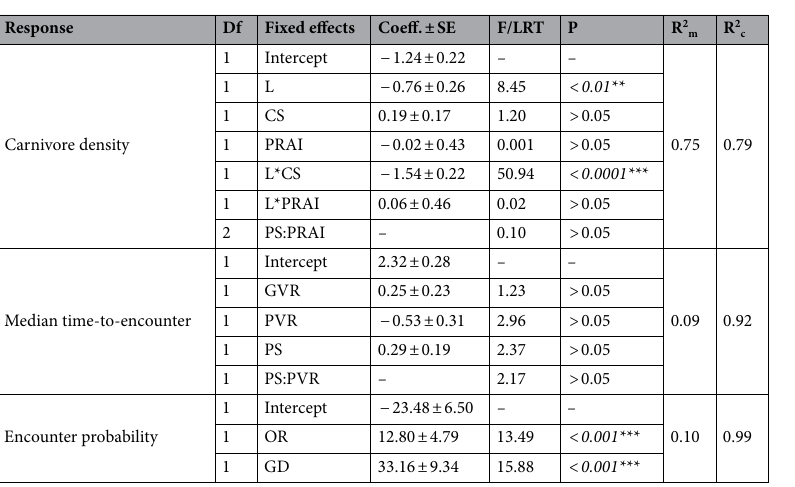
Table 1. Coefficients with standard errors (SE), F or Likelihood ratio test statistics, significance values and marginal and conditional pseudo-R 2 for the independent variables included in the generalized lineal mixed models (GLMM) for carnivore density, median time-to-encounter and encounter probability responses. The variance of the random effect ‘locality’ was 0.01 ± 0.08 (σ ± SE) for carnivore density response. The variance of the random effect ‘cam’ was 0.59 ± 0.77 for median time-to-encounter response and 2630 ± 51.28 for the encounter probability. * L lynx presence/absence, CS carnivore species, PRAI prey relative abundance index, PS prey species, GVR genet visitation rate, PVR prey visitation rate, OR other rodents presence/absence, GD garden dormouse presence/absence. Significant values are in